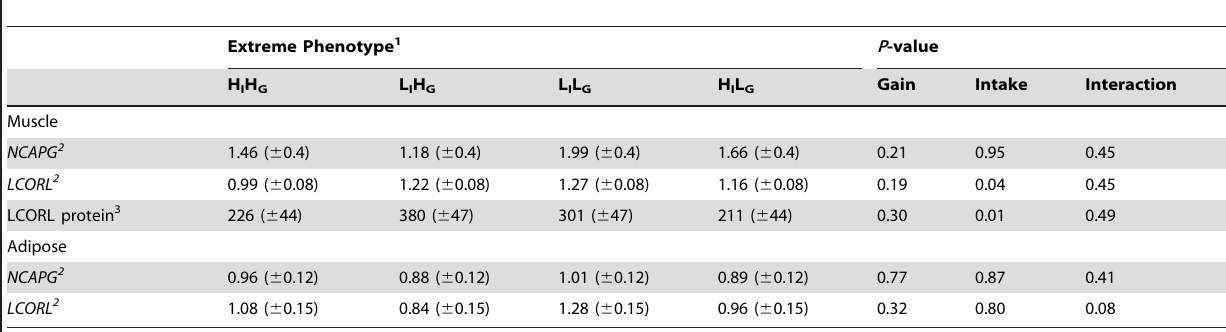
Table 4. LSMeans and standard errors for gene or protein expression and phenotypes in the muscle and adipose tissue of steers.